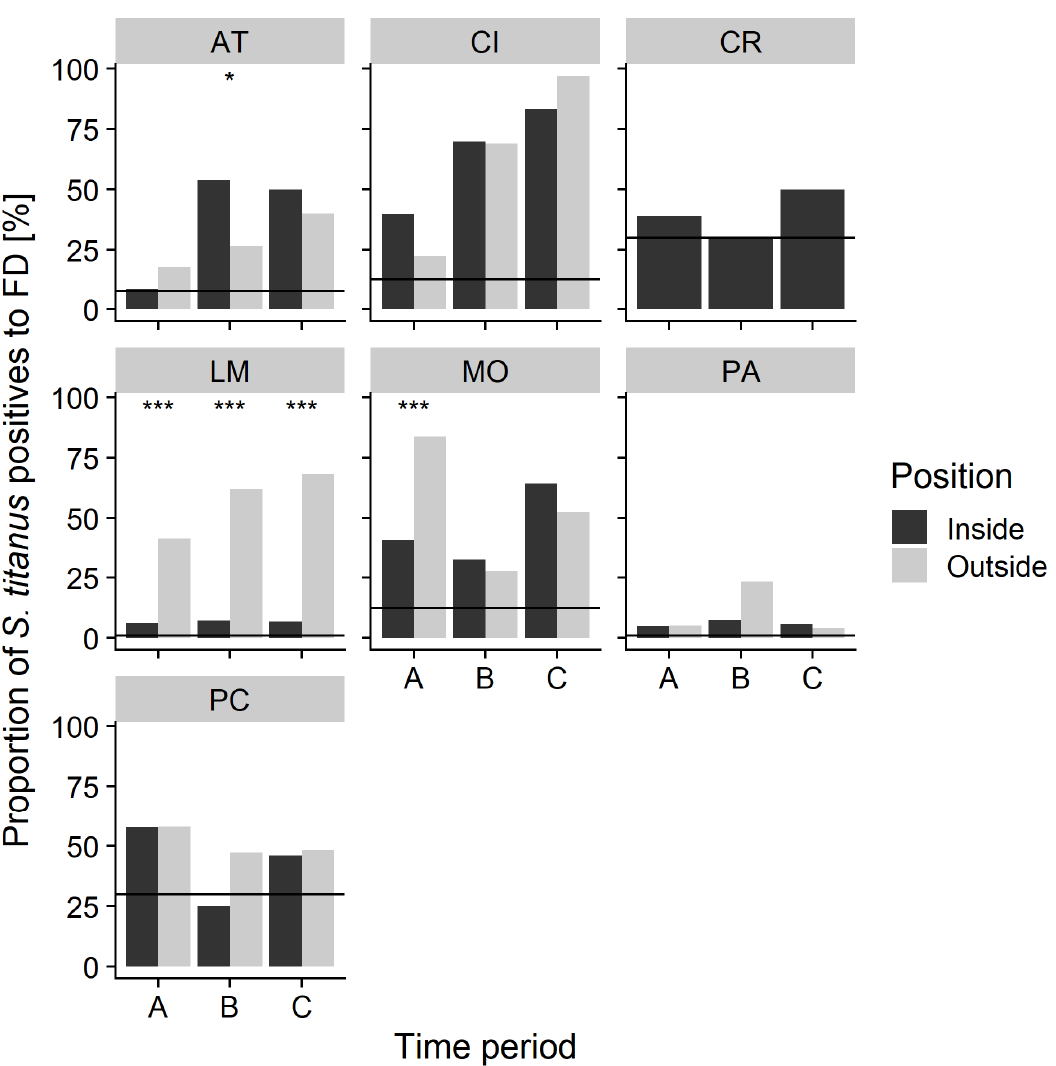
Figure 5. Flavescence dorée phytoplasma infection of S. titanus populations sampled with yellow sticky traps exposed for two weeks inside and outside the different vineyards. Inside and outside levels of infection in the same vineyard are represented. The horizontal black line represents the prevalence of FD-symptomatic grapevines in the vineyard (Table 1). The total number of FDp-tested S. titanus at each vineyard, time point, and trap position is reported in Table S2. Asterisks indicate significant difference between the proportion of FD-infected S. titanus collected inside and outside the vineyard (* p < 0.05; *** p < 0.001).